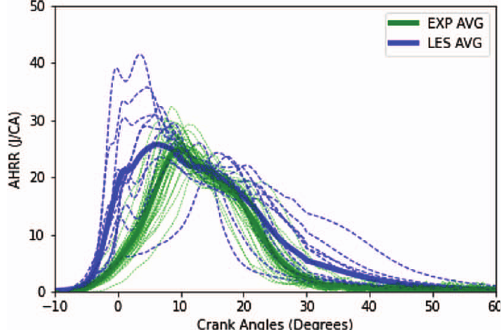
Fig. 12. TFM and LESI ignition model: in-cylinder AHRR for LES (blue) and experiments (green). Individual cycles are denoted by the dashed lines and the ensemble average is denoted by bold lines.